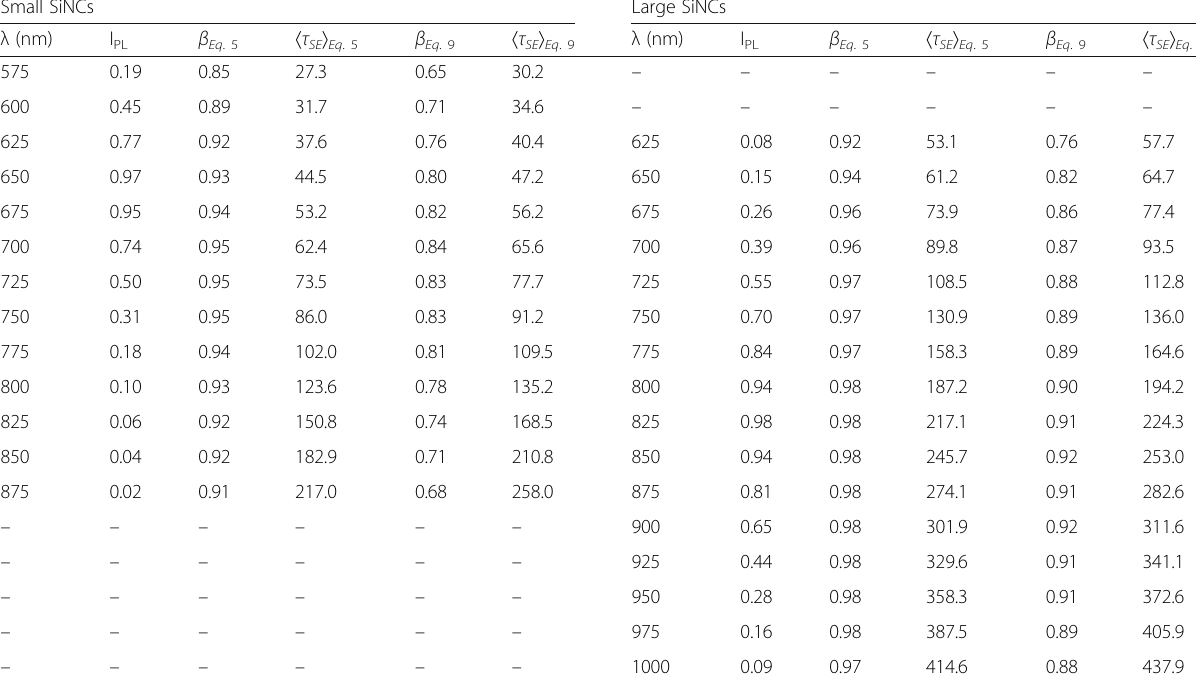
Table 3 Wavelength dependence of the SiNCs lifetimes and fitting parameters obtained from Eq. 5 and 9. The lifetimes changed by almost an order of magnitude across the emission spectrum. The β values were above 0.8 in most cases Small SiNCs Large